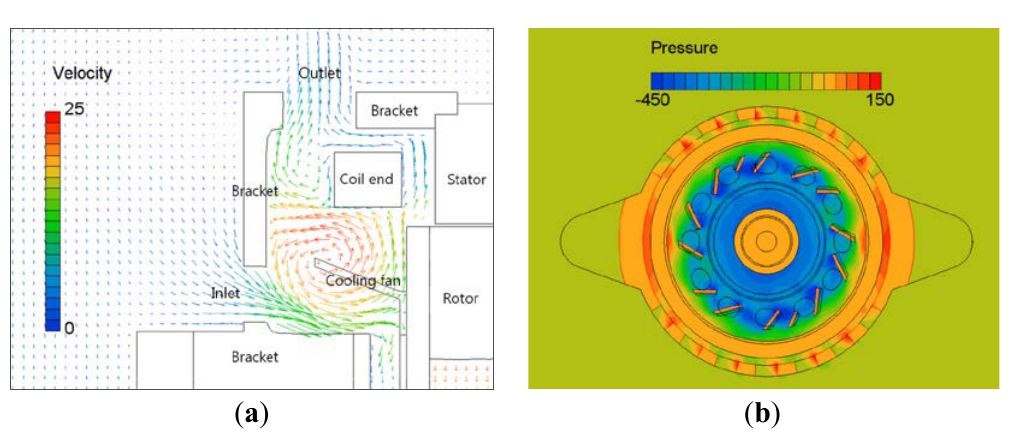
Figure 9. Internal flow of ISG cooling fan @25 °C, 7000 rpm: ( a ) velocity vector (m/s); and ( b ) pressure contours (Pa).